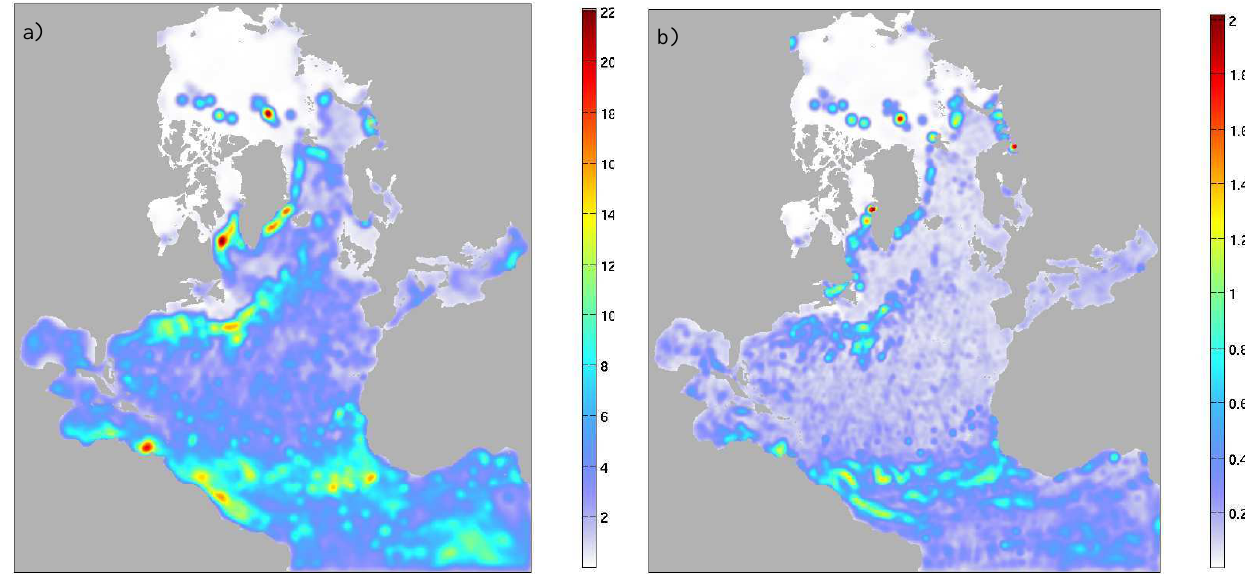
Fig. 3. Example of two-dimensional fields of the local DFS (a) and local SRF (b) ; calculated in the course of the reanalysis for 23 April 2008.